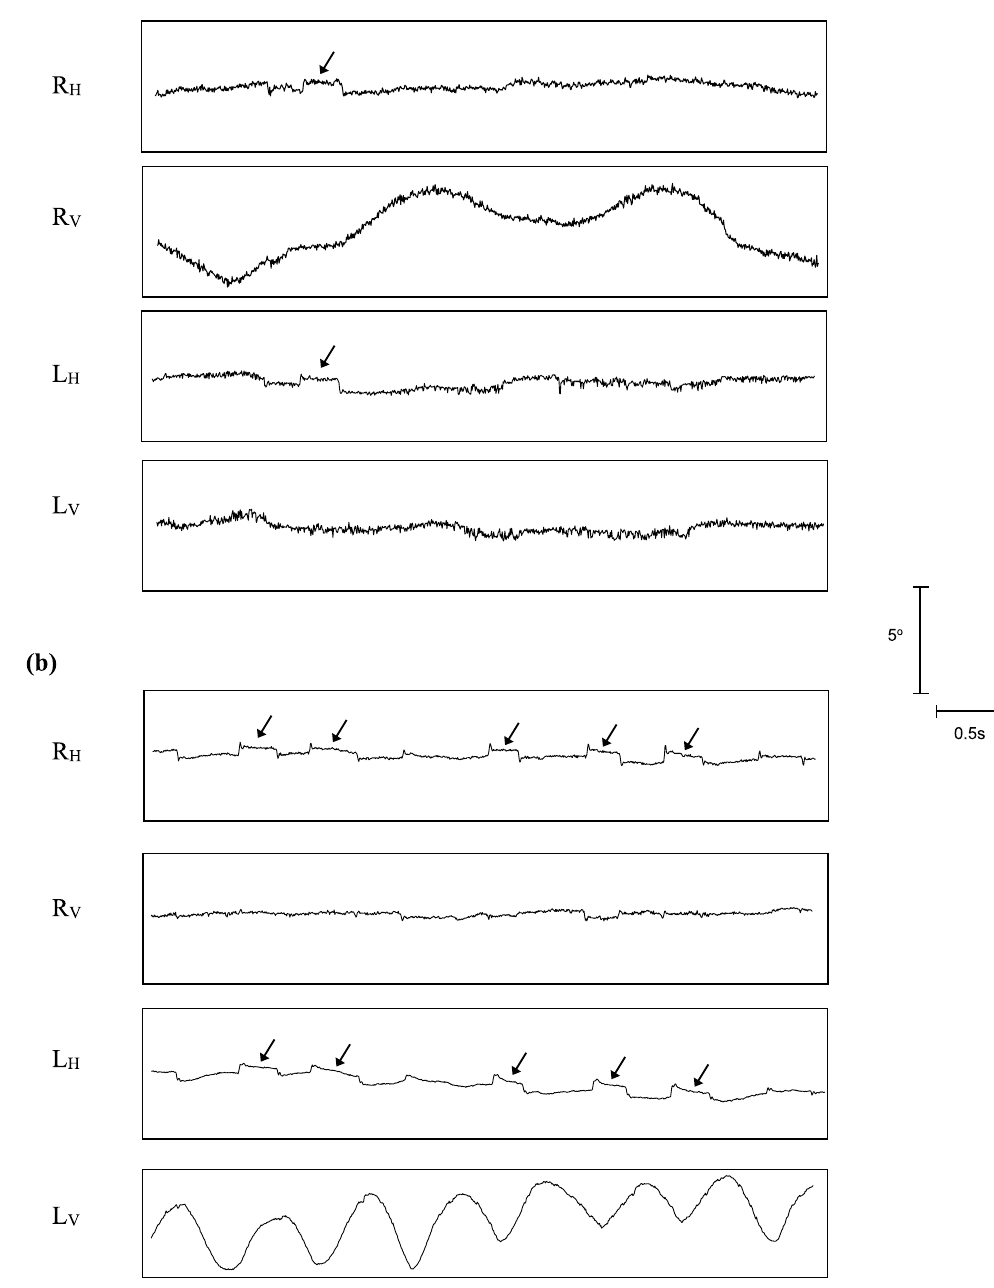
Figure 4. Eye position recordings during binocular viewing of a stationary target located in primary gaze. ( a ) Unilateral vertical nystagmus in the right eye of subject 1. ( b ) Unilateral vertical nystagmus in the left eye of subject 2. R H = right horizontal, R V = right vertical, L H = left horizontal and L V = left vertical. Arrows indicate saccadic intrusions (see text for further